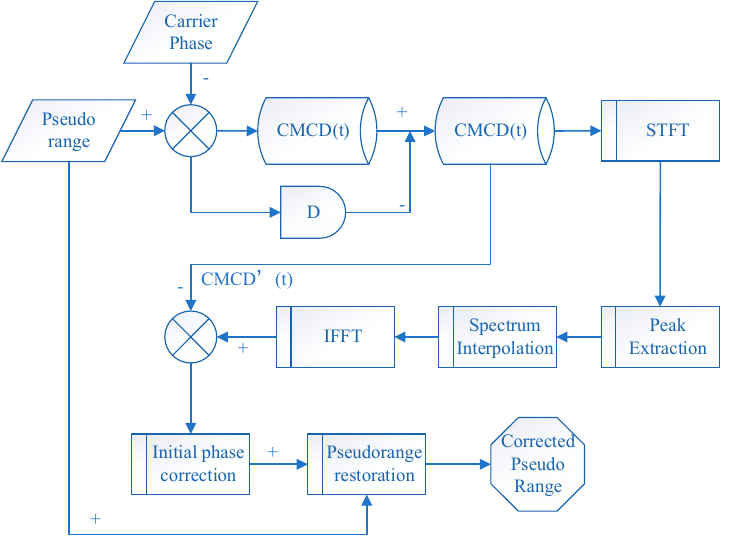
Figure 1. Flow chart of the correction model.